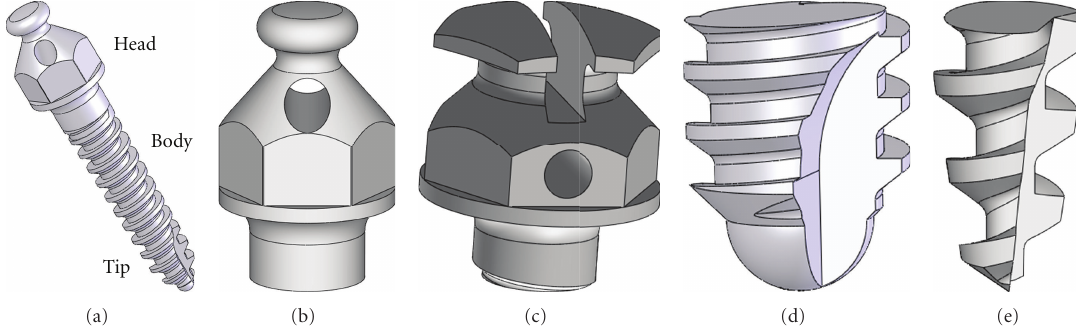
Figure 2: Typical orthodontic implants (a). Head type button (b). Head type bracket (c). Tip type self-tapping (d). Tip type self-drilling (e). (Courtesy of Marcos Joqueira, Conex˜ao Sistemas e Pr´oteses Co. Brazil.)